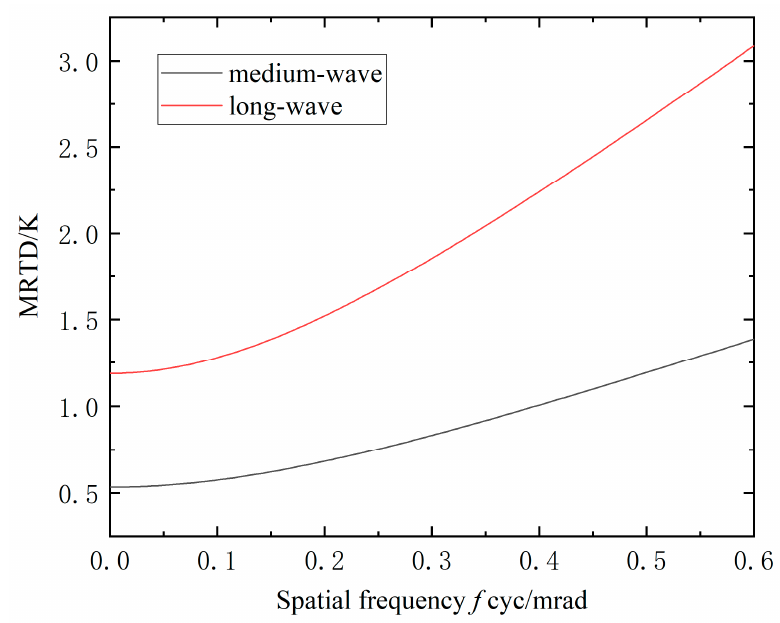
Figure 9. Relationship between spatial frequency f and MRTD (ITD).